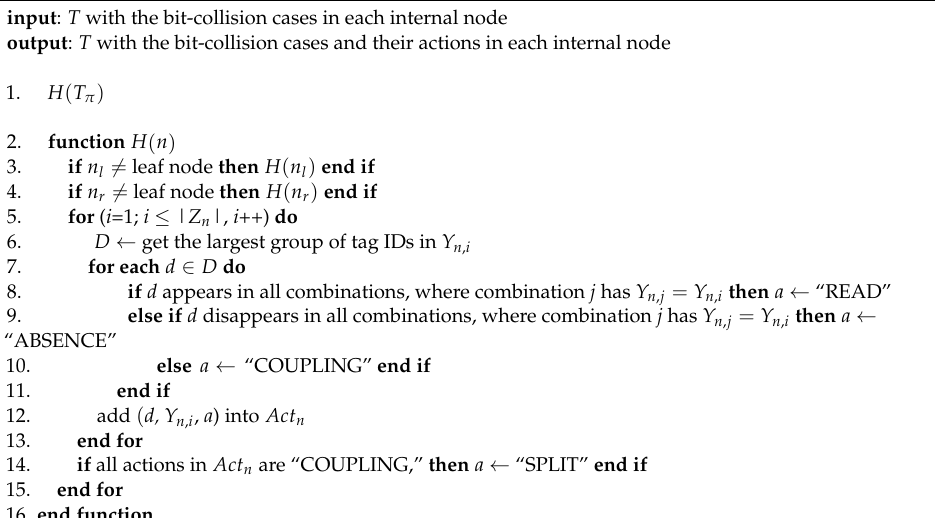
Algorithm 3. Pseudo-code for action